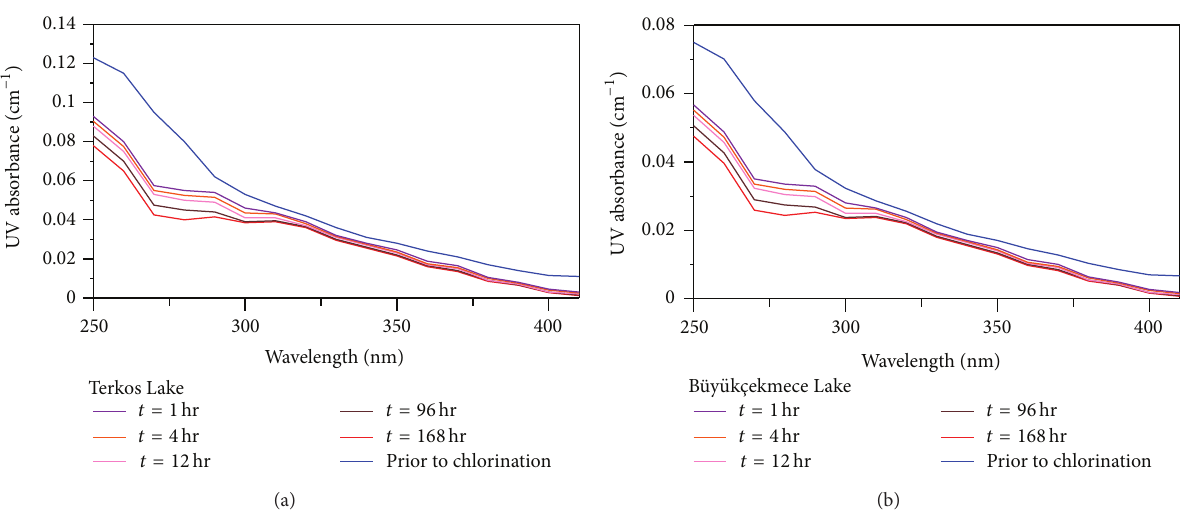
Figure 1: Chlorinated UV absorbance spectra at varying reaction times and at pH 7 for (a) TL water samples and (b) BL water